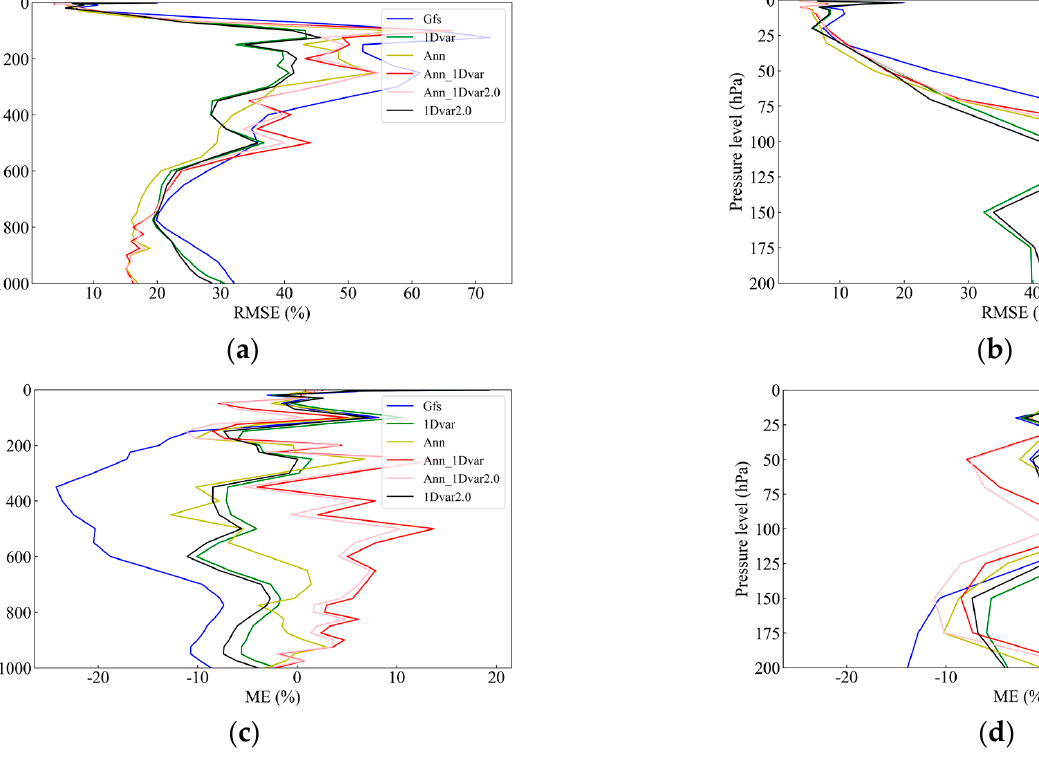
Figure 12. A comparison of the retrieval results after changing temperature and humidity, where the true value is taken from ERA5 data: ( a ) 1–1000 hPa RMSE (%) of two initial profiles and two retrieval profiles, ( b ) 1–200 hPa RMSE (%), ( c ) 1–1000 hPa ME (%), ( d ) 1–200 hPa ME (%). The blue line, GFS, is the ozone profile of GFS forecast data, and the green line, 1Dvar, is the traditional 1D − VAR physical retrieval algorithm retrieval ozone profile result obtained with GFS data as the initial profile. The yellow line, Ann, is the profile obtained by the neural network model and the initial profile synthesized by GFS data, while the red line, Ann_1Dvar, is the retrieval result obtained by adding the neural network method to optimize the initial profile combined with the traditional 1D − VAR physical retrieval algorithm. The pink line, Ann_1Dvar2.0, is the ozone profile obtained by changing the input value of the temperature and humidity profile based on Ann_1Dvar retrieval algorithm. The black line, 1Dvar2.0, is the ozone profile obtained by changing the input value of the temperature and humidity profile based on 1Dvar retrieval algorithm.